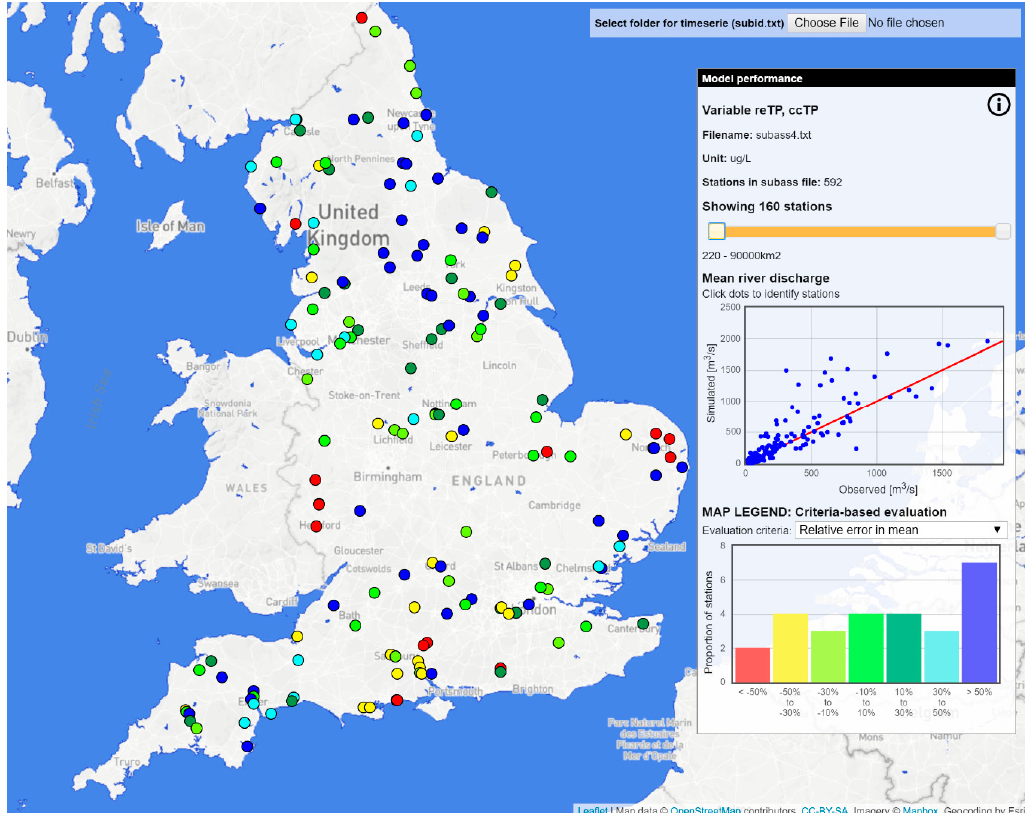
Figure 4. National performance for total P (TP) for catchments > 210 km 2.